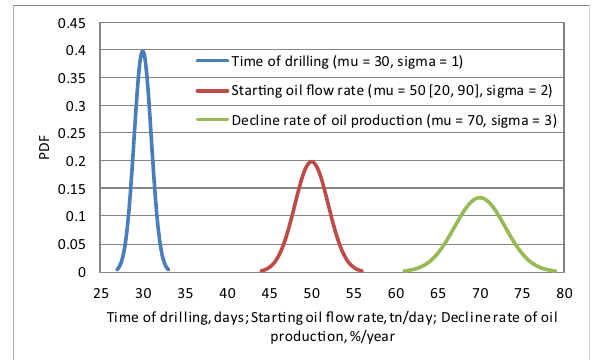
Fig. 12 Performance of the initial and corrected designs for three sce- narios S1 ′ , S2 ′ and S3’